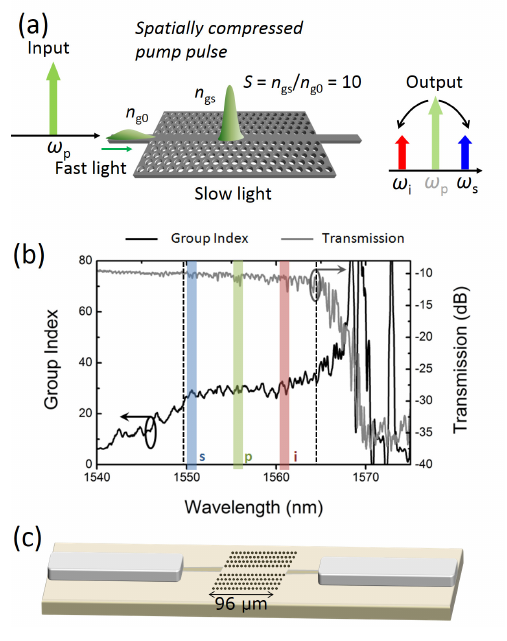
Fig. 6. (a) Schematic of SFWM in a silicon PhC slow-light waveg- uide. (b) Group index and total transmission of light in a 96 µm long PhCW. The window (between dotted lines) with a flat group index of 30 and slightly increased loss defines the slow-light regime. The pump, signal, and idler bands are represented by green (mid- dle), blue (left), and red (right) lines, respectively. (c) Diagram of inversed tapers for a PhCW